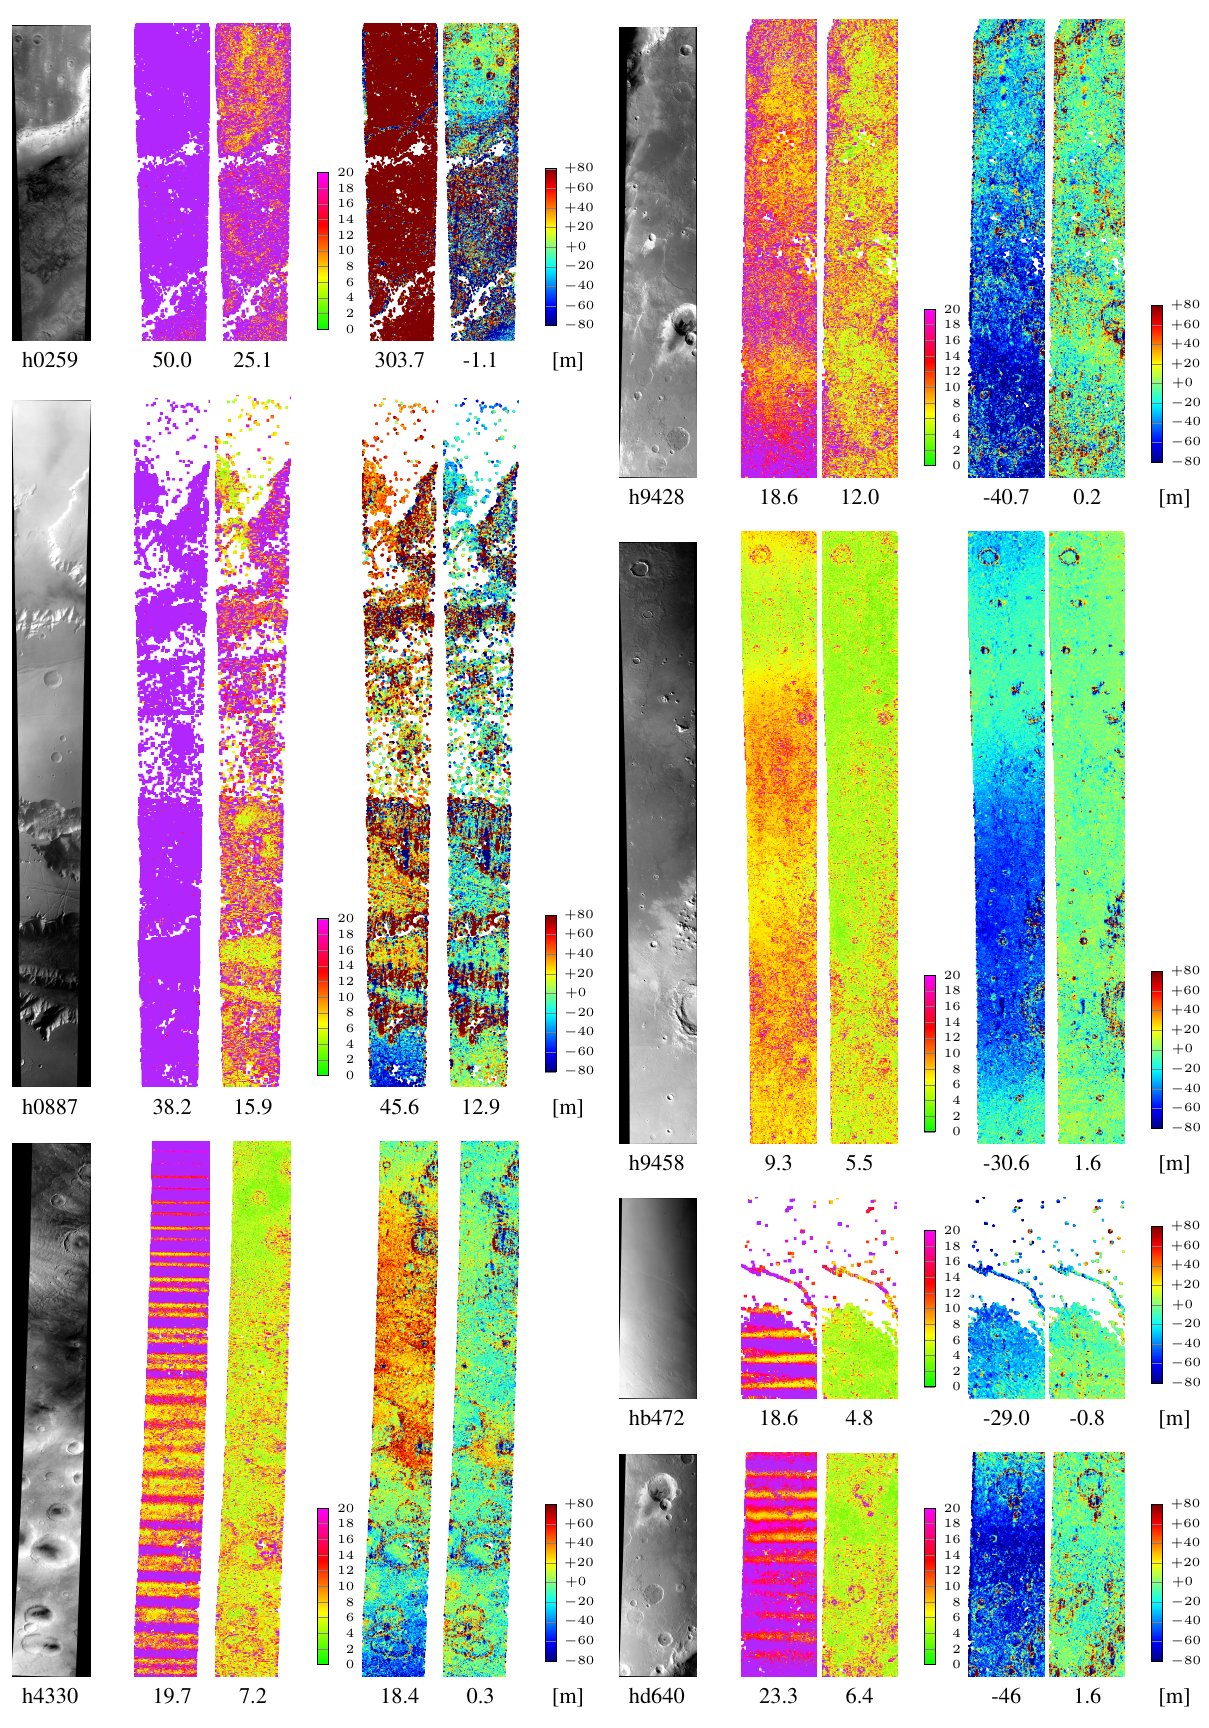
Figure 8: Evaluation of bundle adjustment (BA) results for 7 out of 3686 HRSC data sets as examples. Each from left to right: 1) nadir ortho image with orbit number; error maps with mean values for: intersection error 2) without BA and 3) with BA (vOPD), height differences between HRSC points and MOLA DTM 4) without BA and 5) with BA